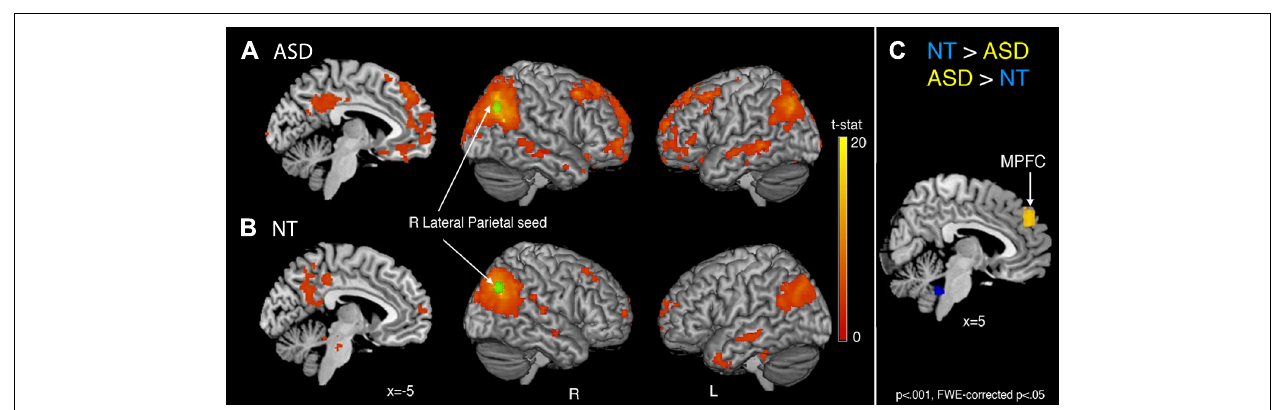
FIGURE 1 | Correlation matrices for neurotypical (A) andASD (B) groups . Normalized correlation coefficients are reported for each of the 34 × 34 ROI correlations by group.These are organized by network based on Fair etal. (2009) (CO, cingulo-opercular; C, cerebellar; DMN, default mode network; FP, fronto-parietal). Each row is labeled with a number which corresponds to 1 of